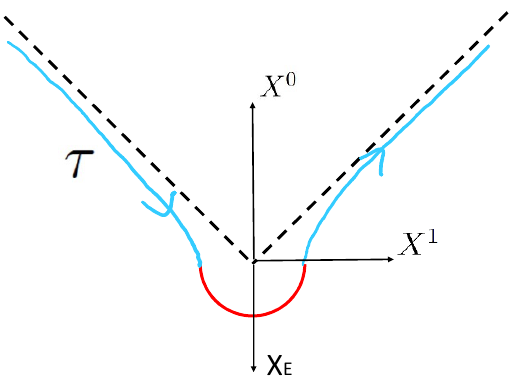
Figure 3 . The Schwinger mechanism. The red line represents the Euclidean solution. It is glued at X E = X 0 = 0 to the Minkowskian solution that is represented by the blue lines.